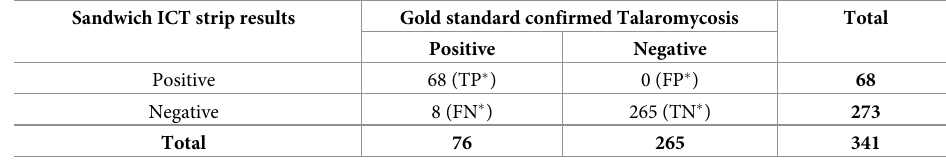
Table 3. Two by Two table analysis of diagnostic performance of GNA-MAb 4D1 sandwich ICT strip.